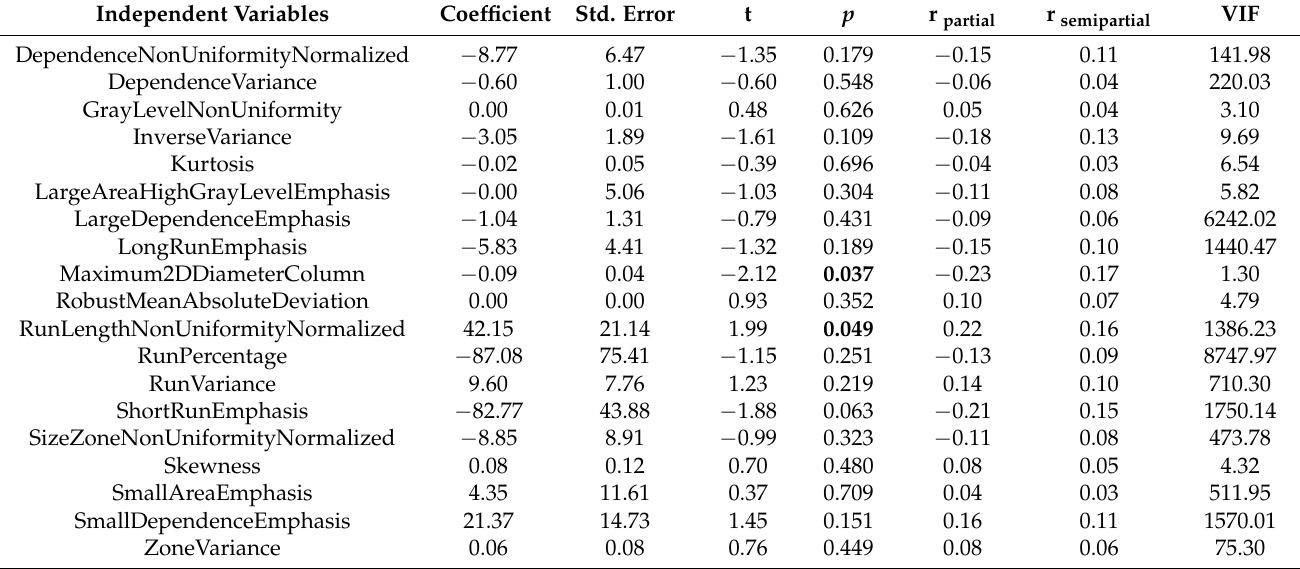
Table 3. Multivariate analysis results. Bold values are statistically